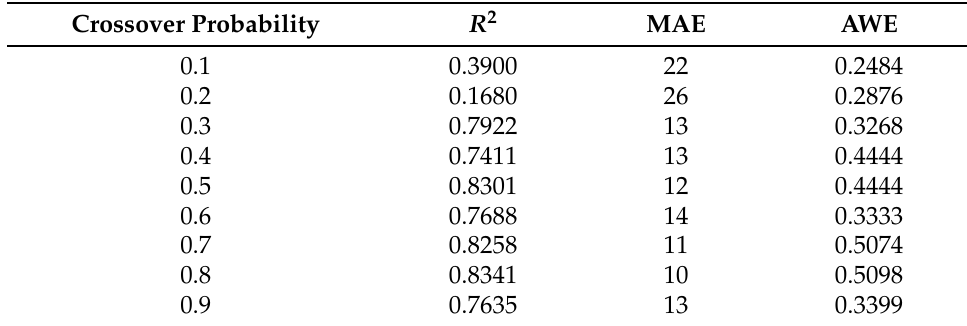
Table 7. Adjustment evaluation table of cross probability of hyperparameters in GA-BP model.